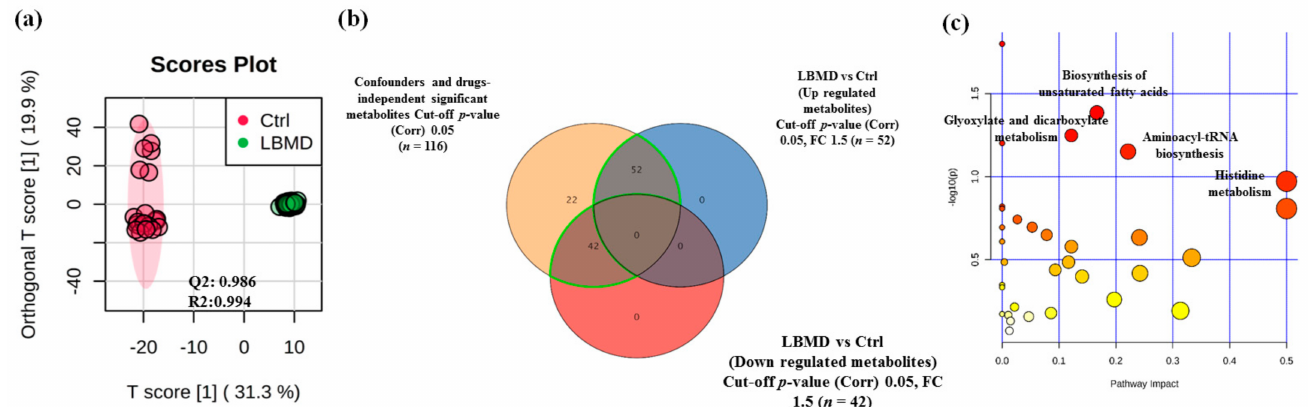
Figure 3. Metabolomics profiling of LBMD and controls. ( a ) An orthogonal partial least squares discriminant (OPLS-DA) analysis of the LBMD versus control metabolomics profile demonstrating clear cluster segregation between both groups ( Q 2 = 0.986, R 2 = 0.994). ( b ) Venn diagram showing the dysregulated metabolites detected between LBMD and control groups after applying the fold-change (FC cutoff = 1.5 and p -value < 0.05), where 52 and 42 metabolites were up- and downregulated (total 94 metabolites) in LBMD patients compared to control, respectively. ( c ) A pathway analysis plot demonstrating the main pathways involved in the metabolic alterations based on the 94 dysregulated